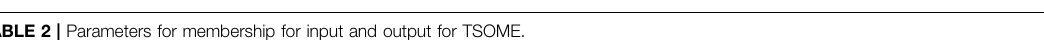
algorithm, and (3) model testing and validation. Twenty samples of the dataset were considered for the experiment, with 70%